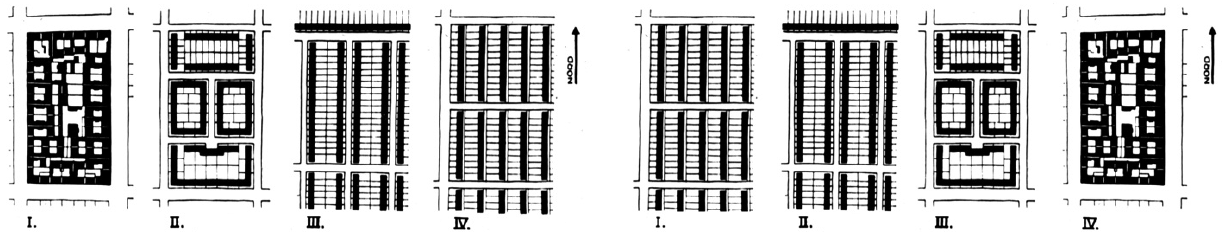
Figure 25. Entwicklung des Blocks in der Stadt [Development of the block in the city], 1930, original and mirrored diagram. Source: May